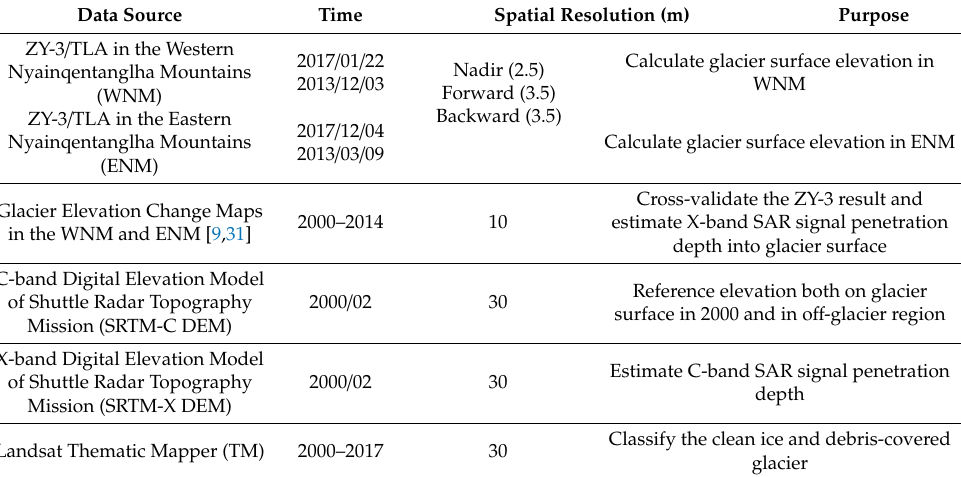
Table 1. Input and reference datasets used in this paper.